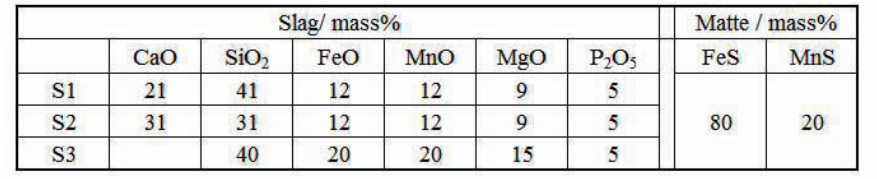
Table 1. Initial compositions of slag and matte.